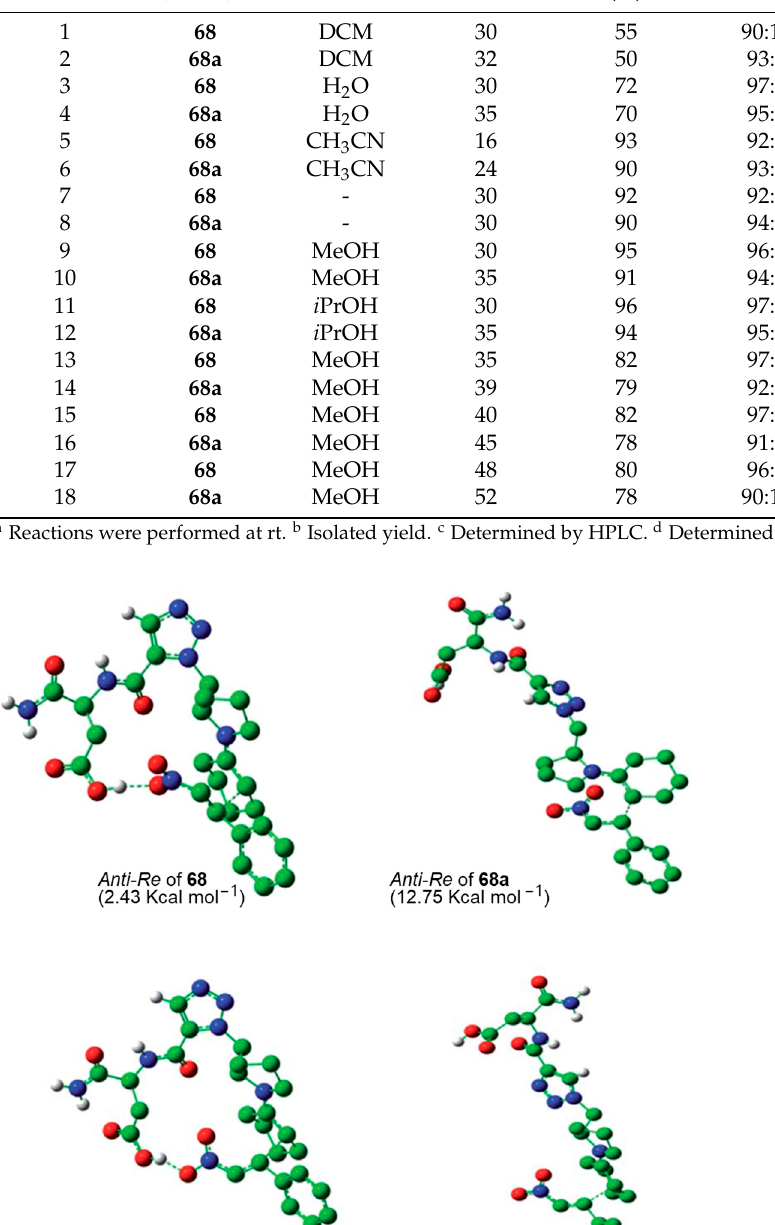
Table 6. Asymmetric Michael addition performed by peptidomimetic triazole-based catalysts.